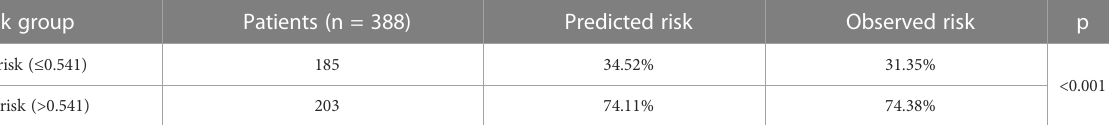
TABLE 6 Risk strati fi cation of patients in the internal validation cohort based on the ensemble